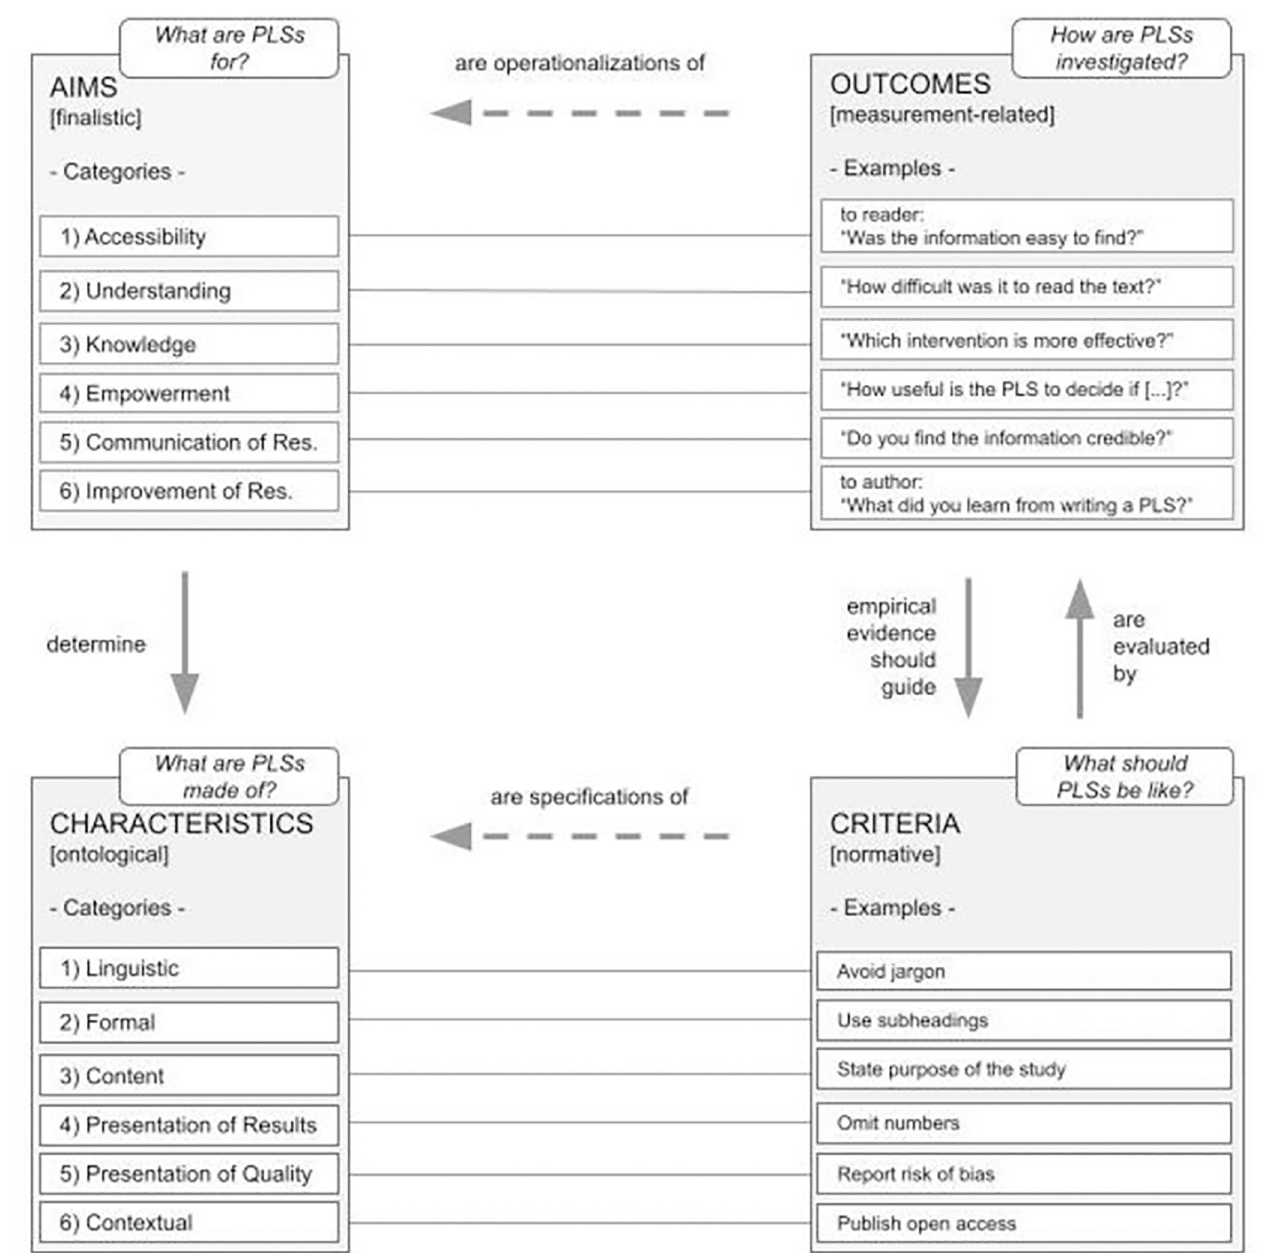
Fig 3. Conceptual framework of aims, characteristics, criteria and outcomes investigated in PLS